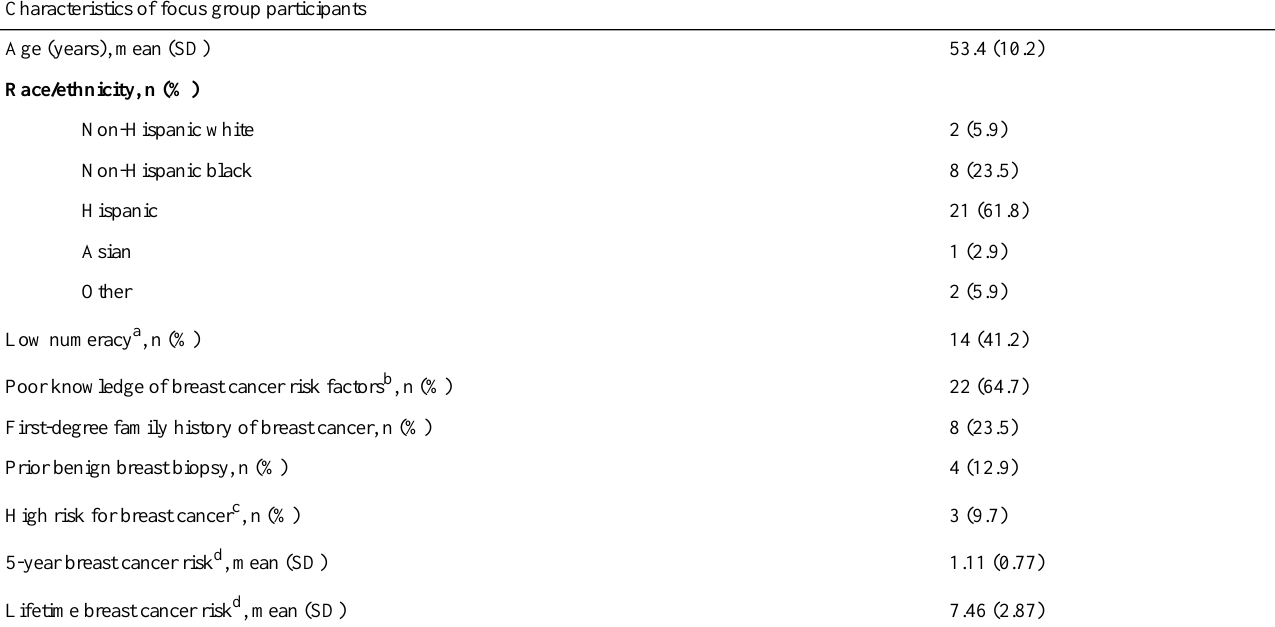
Table 1. Baseline characteristics of focus group participants (N=34), New York City (2013). Characteristics of focus group